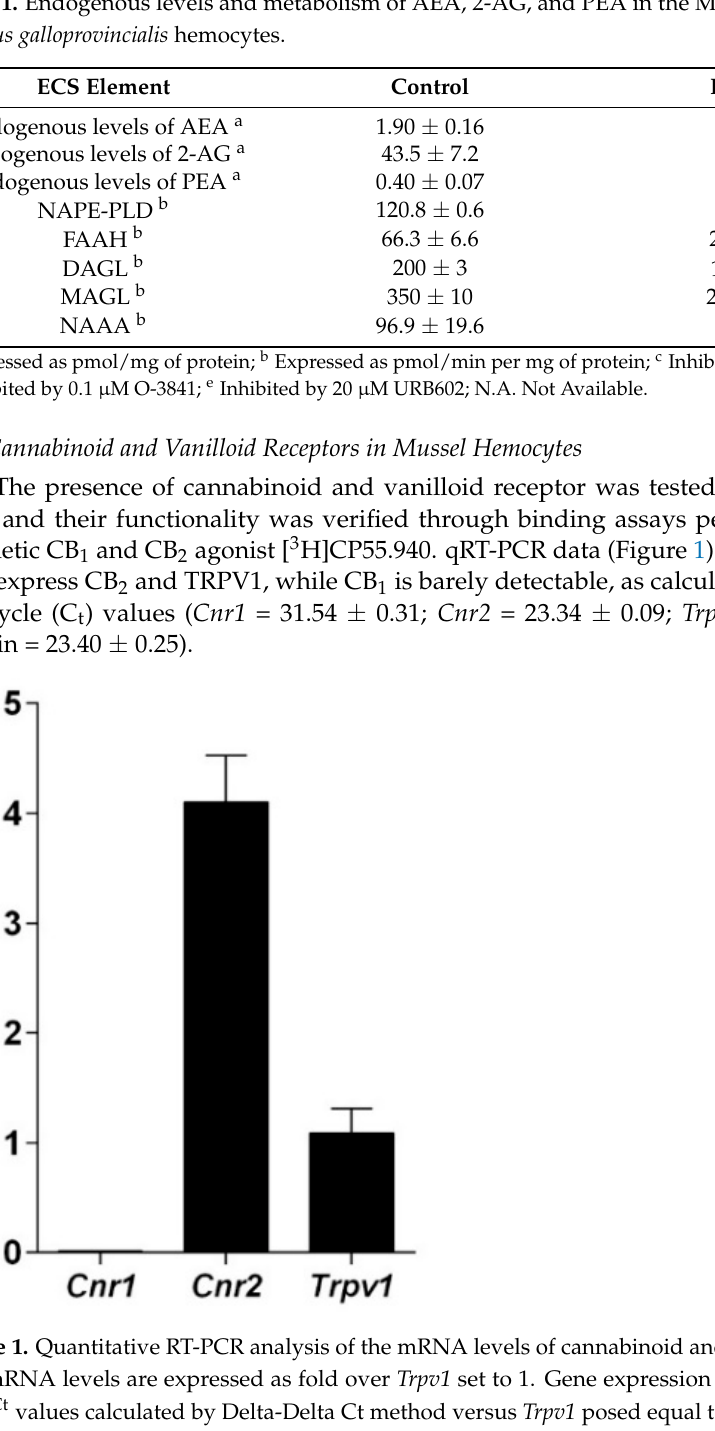
Incidentally, it should be underlined that specific amplification products were ob- tained only when human, but not mouse and rat, primers were used for DNA recognition.